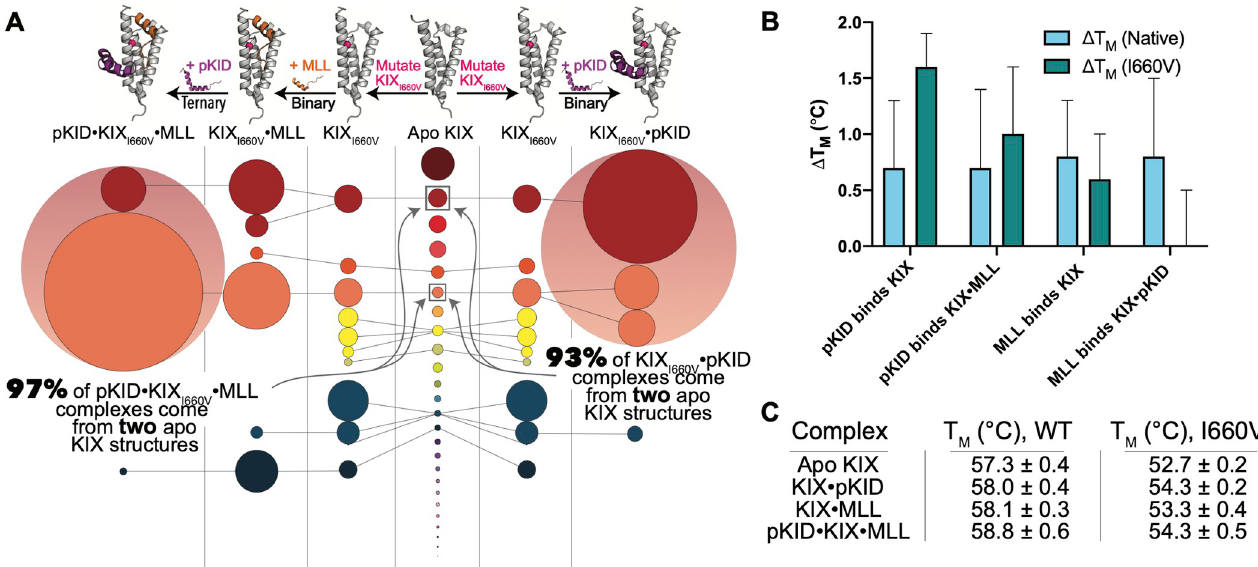
Fig 4. (A) Pathways of KIX conformational selection in the mutant (I660V) pKID system. Circles represent KIX micro-state basins that come from K-means clustering analysis, and the diameter of each circle is proportional to the relative population. Circle colors correspond to the cluster origin from the apo KIX distribution. (Left) The diminishing states pathways in conformational selection when MLL binds first in ternary complex formation and (right) when the KIX I660V •pKID forms the binary complex. (B) Changes in melting temperatures determined via DSF in the native KIX system (light blue) and the mutant KIX I660V system (teal), with individual melting temperatures of both the wild type (WT) KIX and the mutant KIX I660V systems shown in (C).